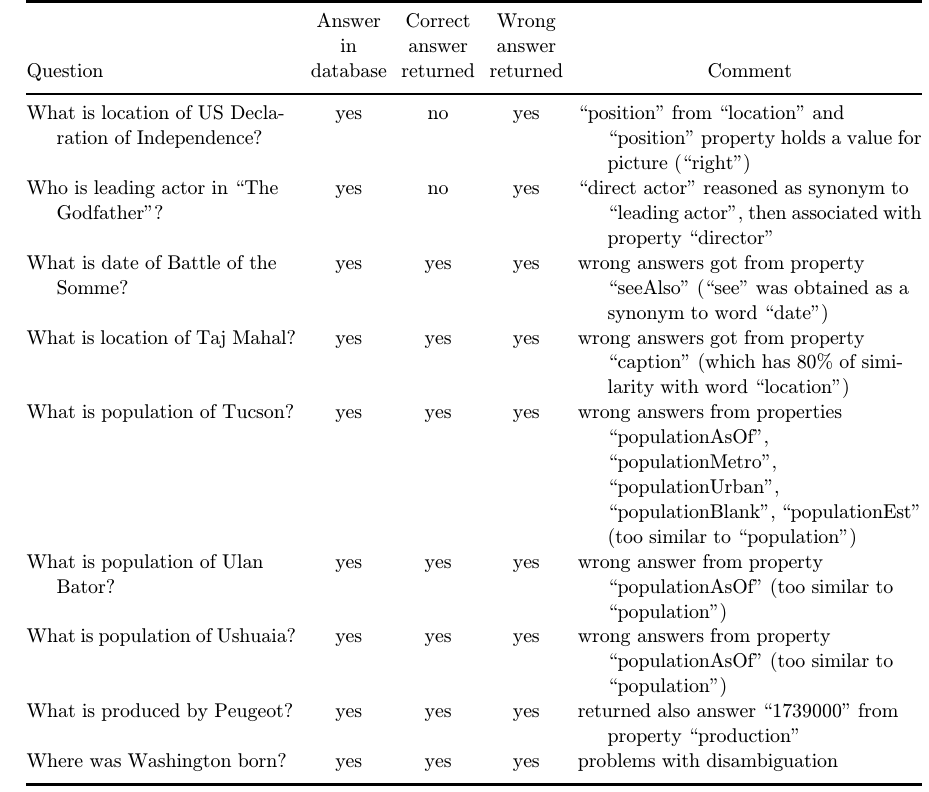
Table 4. Examples of questions with wrong